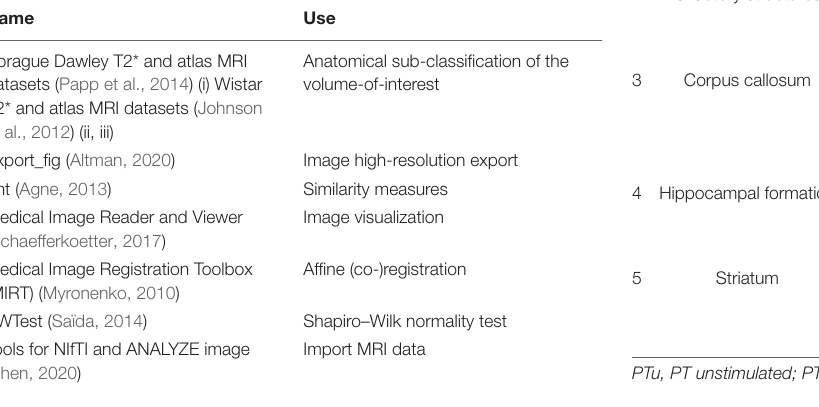
TABLE 1 | Overview of the datasets, functions and toolboxes additionally included to the Matlab implemented toolboxes.